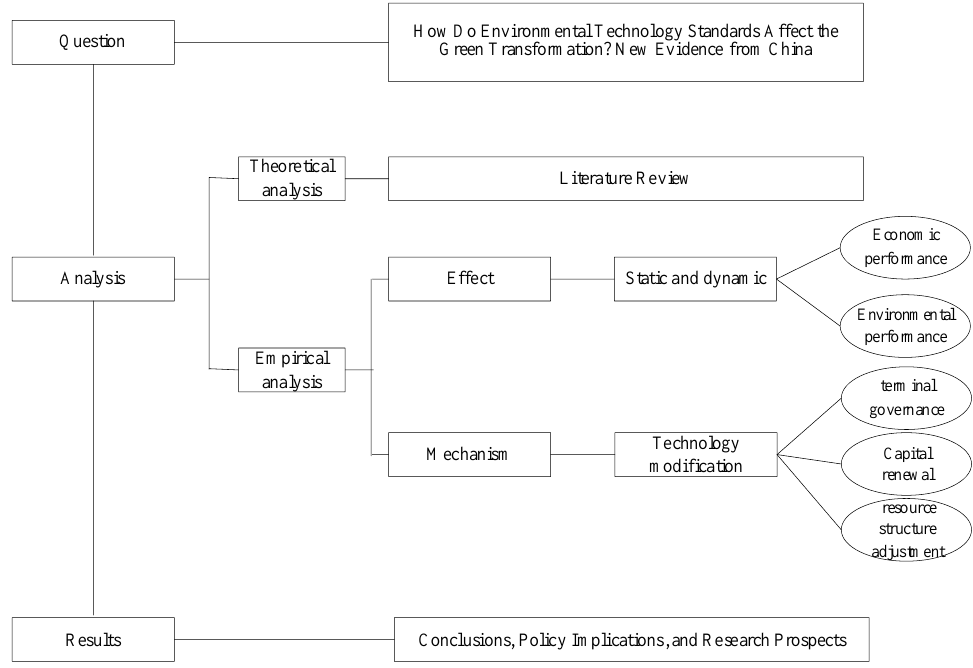
Figure 1. Flowchart of research steps.